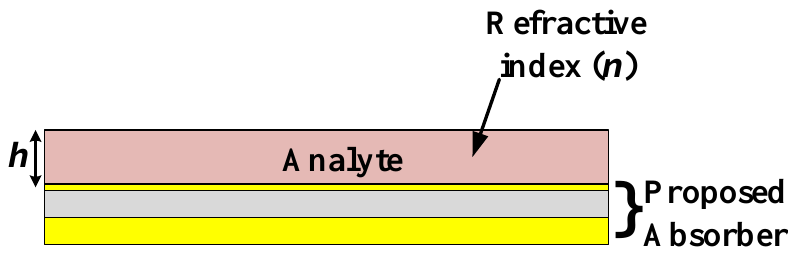
Figure 6. Proposed absorber as a dual sensor for sensing refractive index of the analyte and its height. The refractive index of the analyte varied between 1 and 1.4, while the analyte thickness